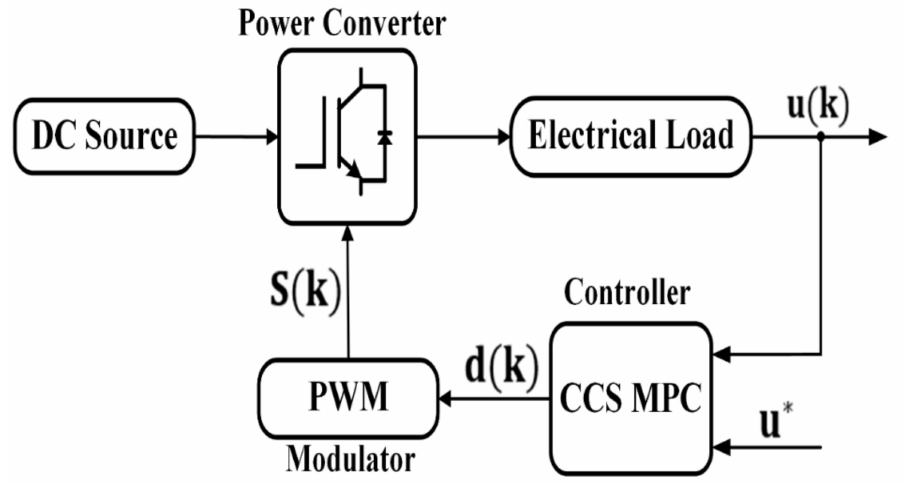
Figure 2. CCS PC